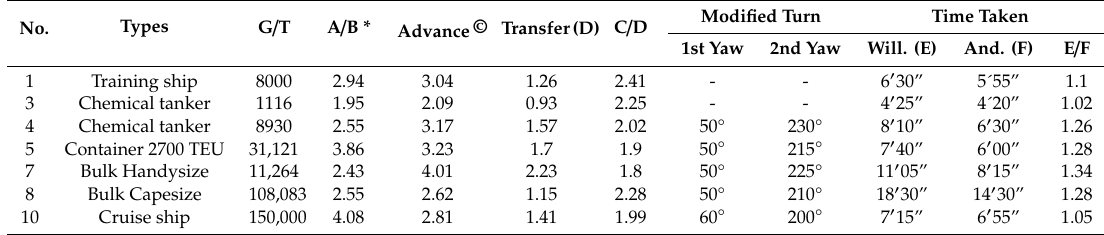
Table 8. Summary of